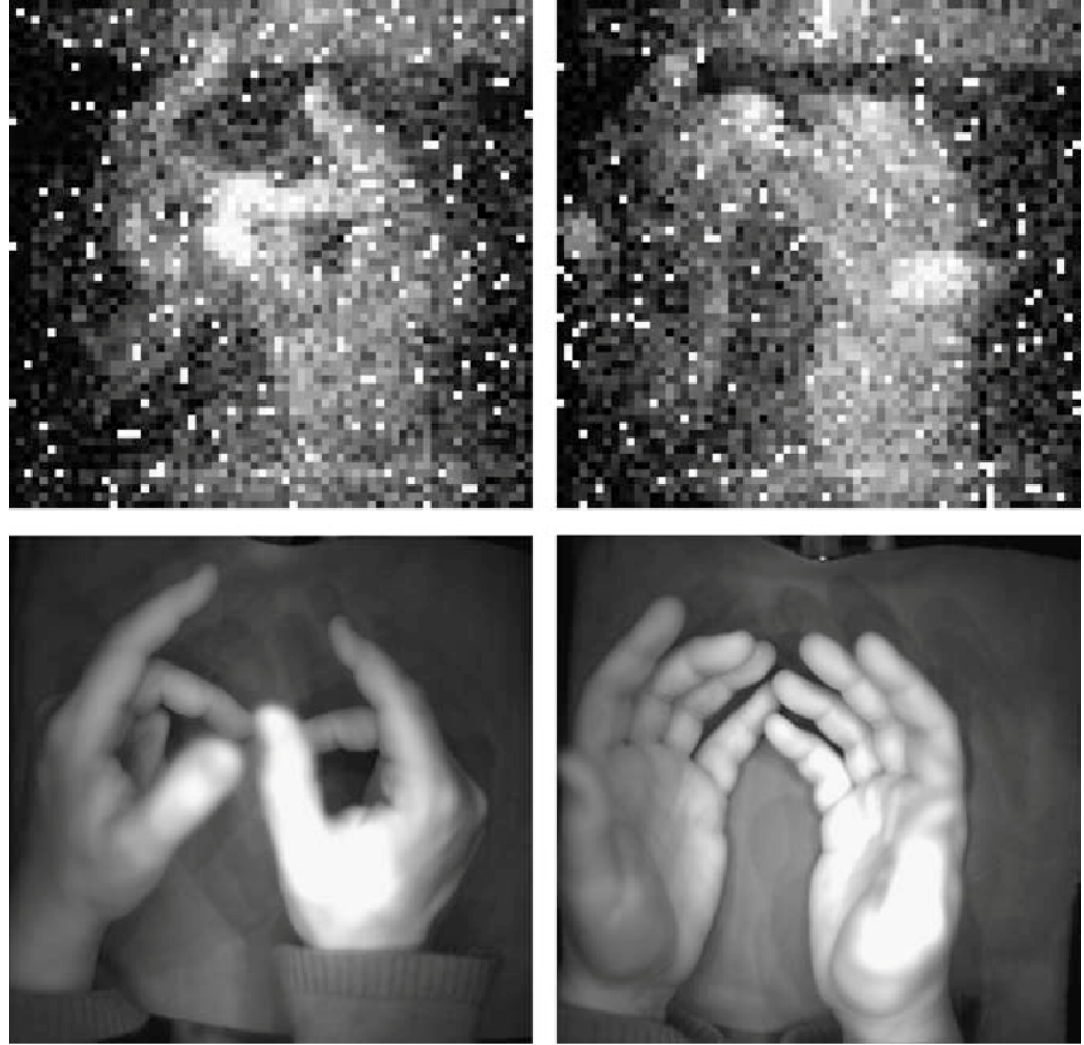
Figure 3. Top images are 10-min exposures taken in total darkness using 20 × 20 binning with a Princeton Instruments VersArray 1300B camera (Teledyne Princeton Instruments, New Jersey, USA) cooled to − 100 °C. Bottom images are 10 ms exposures taken with white-light illumination. Reprinted from [77]. The top and bottom images are captures of the same situation/subject with different techniques. The top images are the pixelized representation of biophoton emissions obtained with a cooled, low-noise CCD camera in total darkness (biophoton emission: fingertips > palms > back of the hands). The bottom images were obtained with white-light illumination.